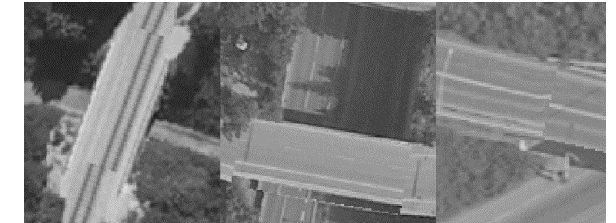
Figure 6. Deformations or spatial discrepancies on orthogonalized photographs. Inaccurate object position (left), Figure 3. DMR 4G replenished by changing altitudes of model inaccurate object altitude (midst) and dissension object with points (up) and its impact to the orthorectified aerial photograph DTM (down)